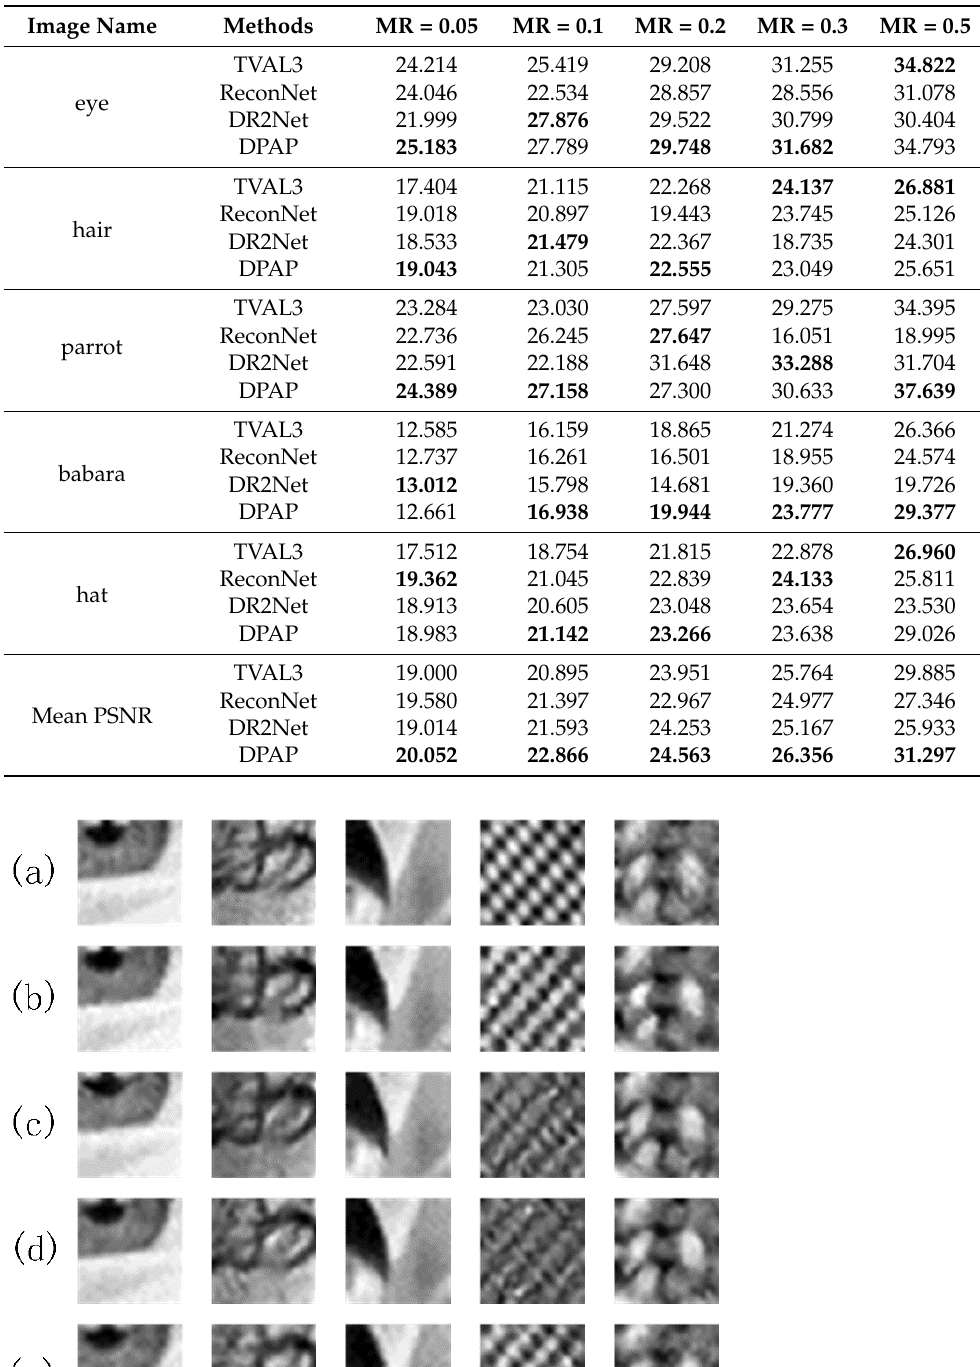
Table 4. Reconstructed PSNR of 5 test images using different networks at different measurement rates.